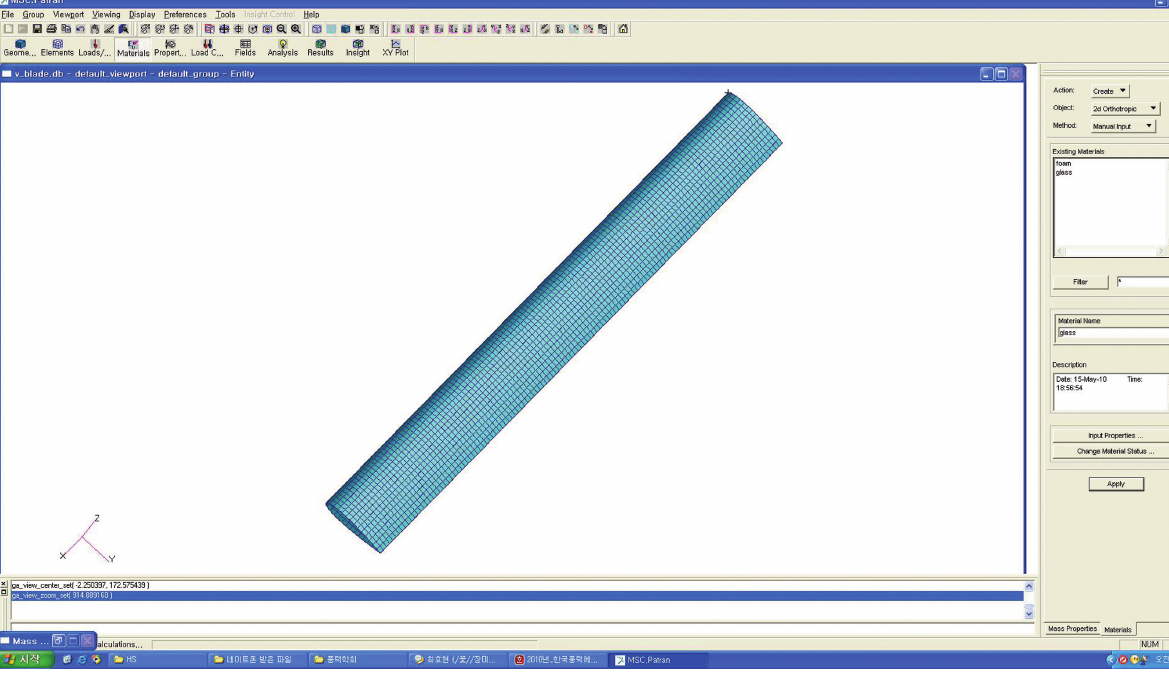
From stresses calculated by the load spectrum and the S-N curve used for spar shown as Figure 14, the fatigue life N at average stress level S can be estimated. If the i i number of applied load cycles n at average stress i